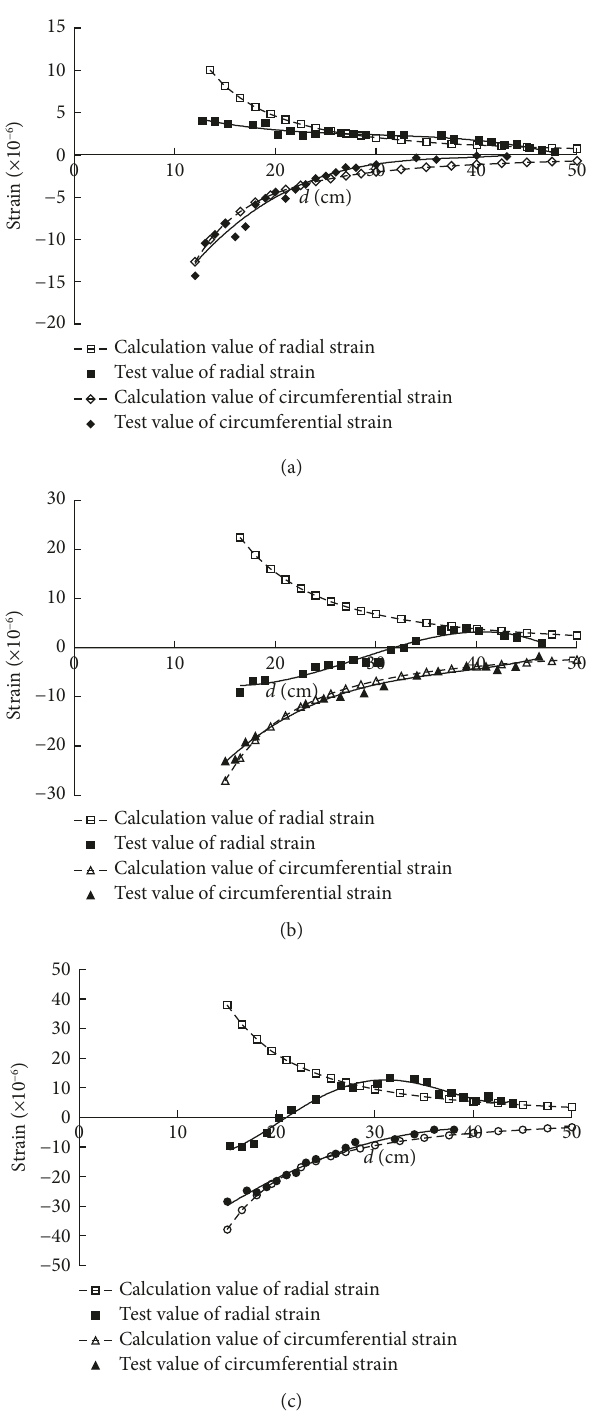
Figure 16: Test results and calculation values of strain. (a) CC. (b) CSM. (c) AC.